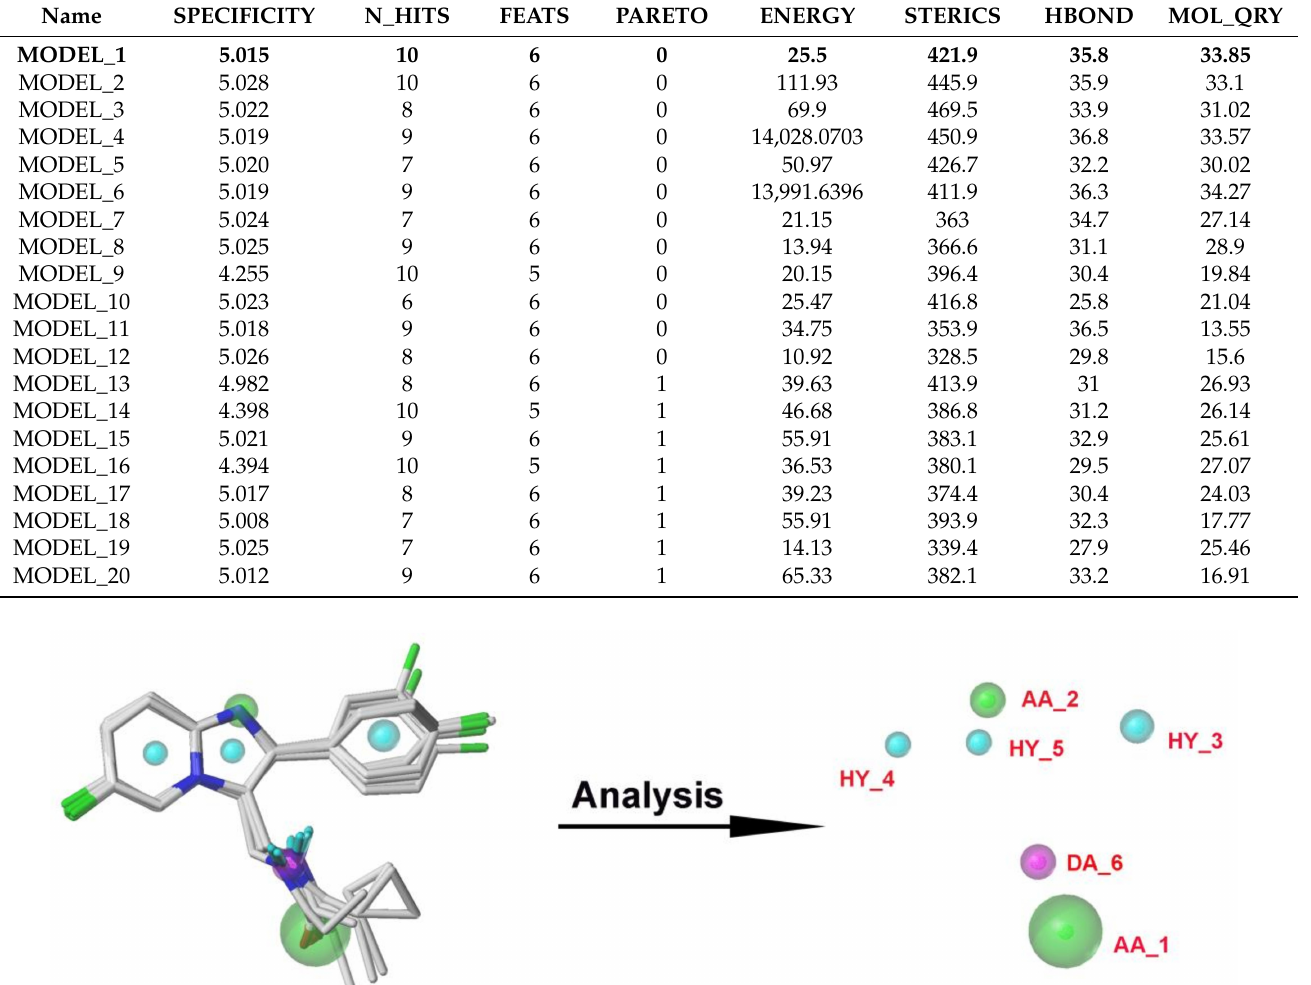
Figure 9. The pharmacophore model constructed with GALAHAD. Green, magenta, cyan, and blue spheres represent hydrogen bond acceptor atoms (AAs), hydrogen bond donor atoms (DAs), and hydrophobes (HYs),